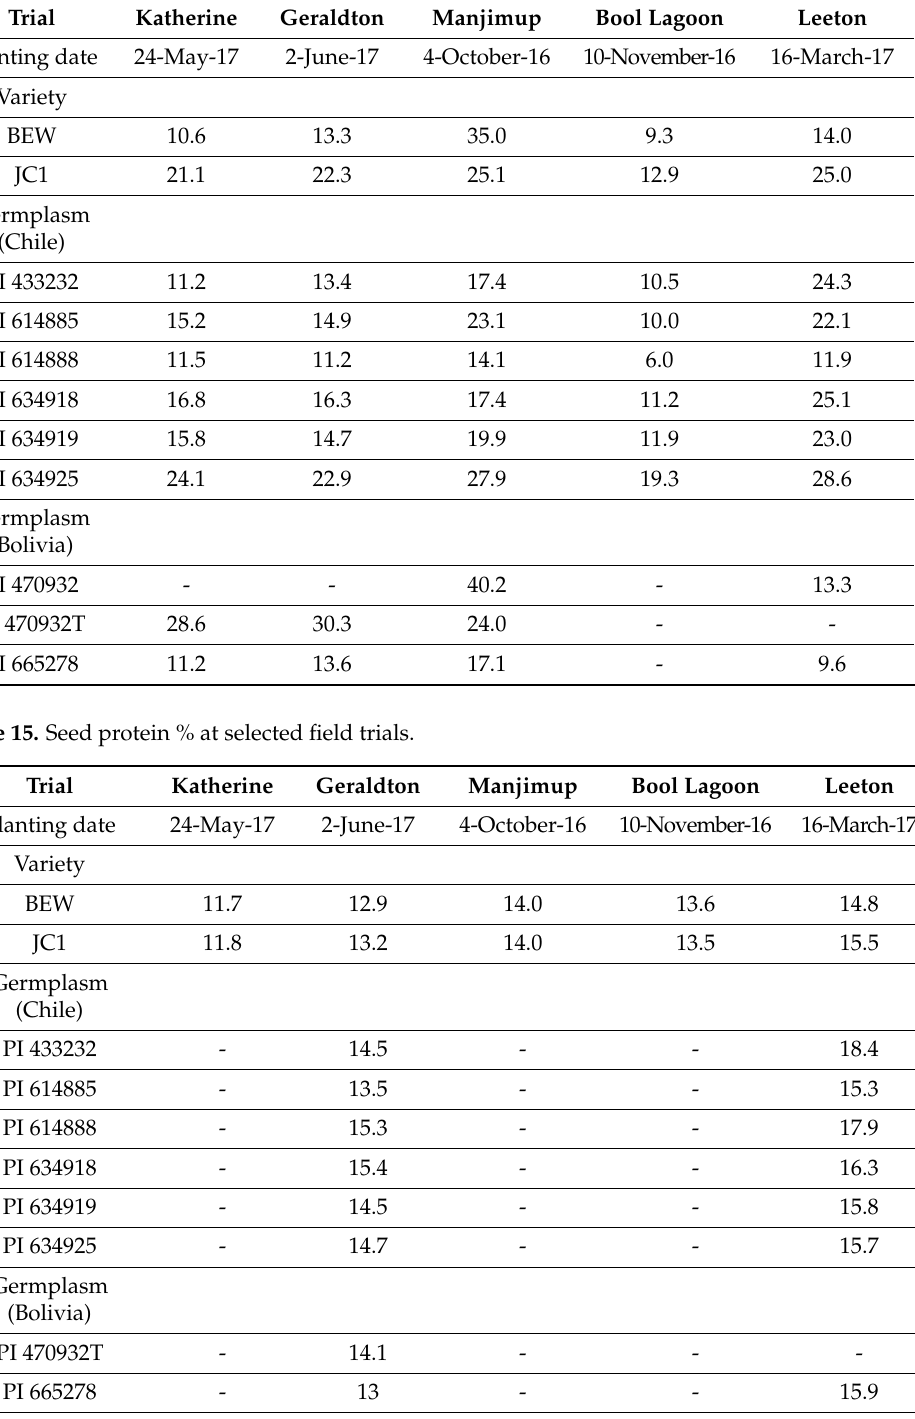
Table 14. Colour difference index or comparison of the sample colour with the colour of imported white quinoa from Peru ( ∆ E*ab). LSD ( p = 0.05) = 6.1 (varieties), 5.4 (varieties × sites). Trial